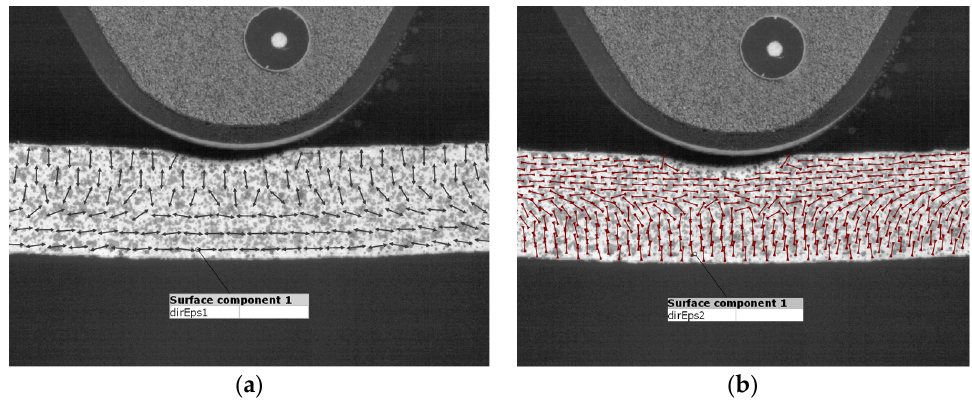
Figure 3. ( a ) Random pattern and applied grid; ( b ) Measurement grid “tied” to the sample surface.